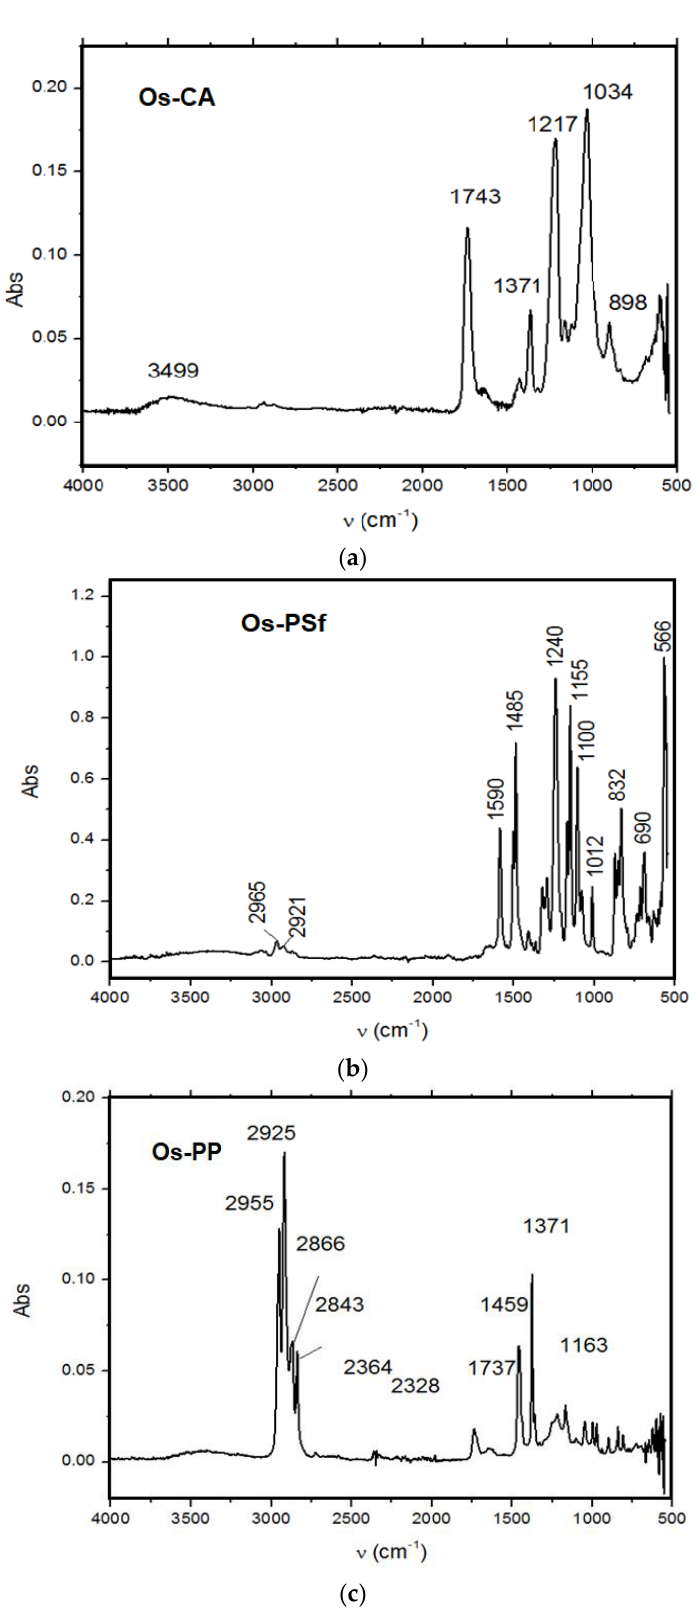
Figure 16. Fourier Transform Infra-Red spectroscopy (FTIR) spectrum of: ( a ) osmium–cellulose acetate membrane (OS–CA); ( b ) osmium–polysulfone membrane (Os–PSf); and ( c ) osmium– polypropylene hollow fiber membranes